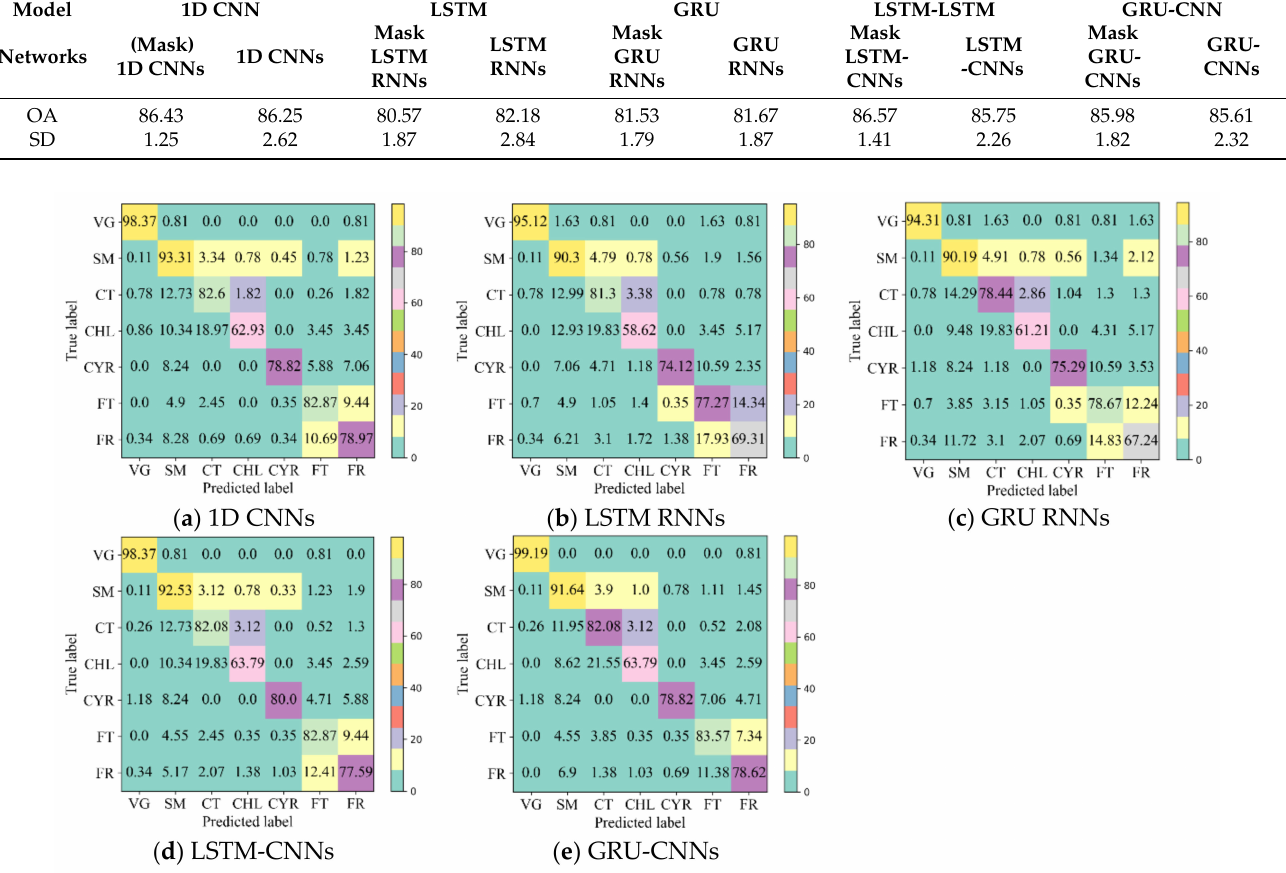
Figure 10. ( a – e ) Confusion matrices of different networks using filled Sentinel-2 time series data. Values in matrices are the percentage of points available in the “true label” and are the average of the five test sets. VG, vegetable greenhouse; SM, summer maize; CT, cotton; CHL, chili; CYR, common yam rhizome; FT, fruit trees; FR,